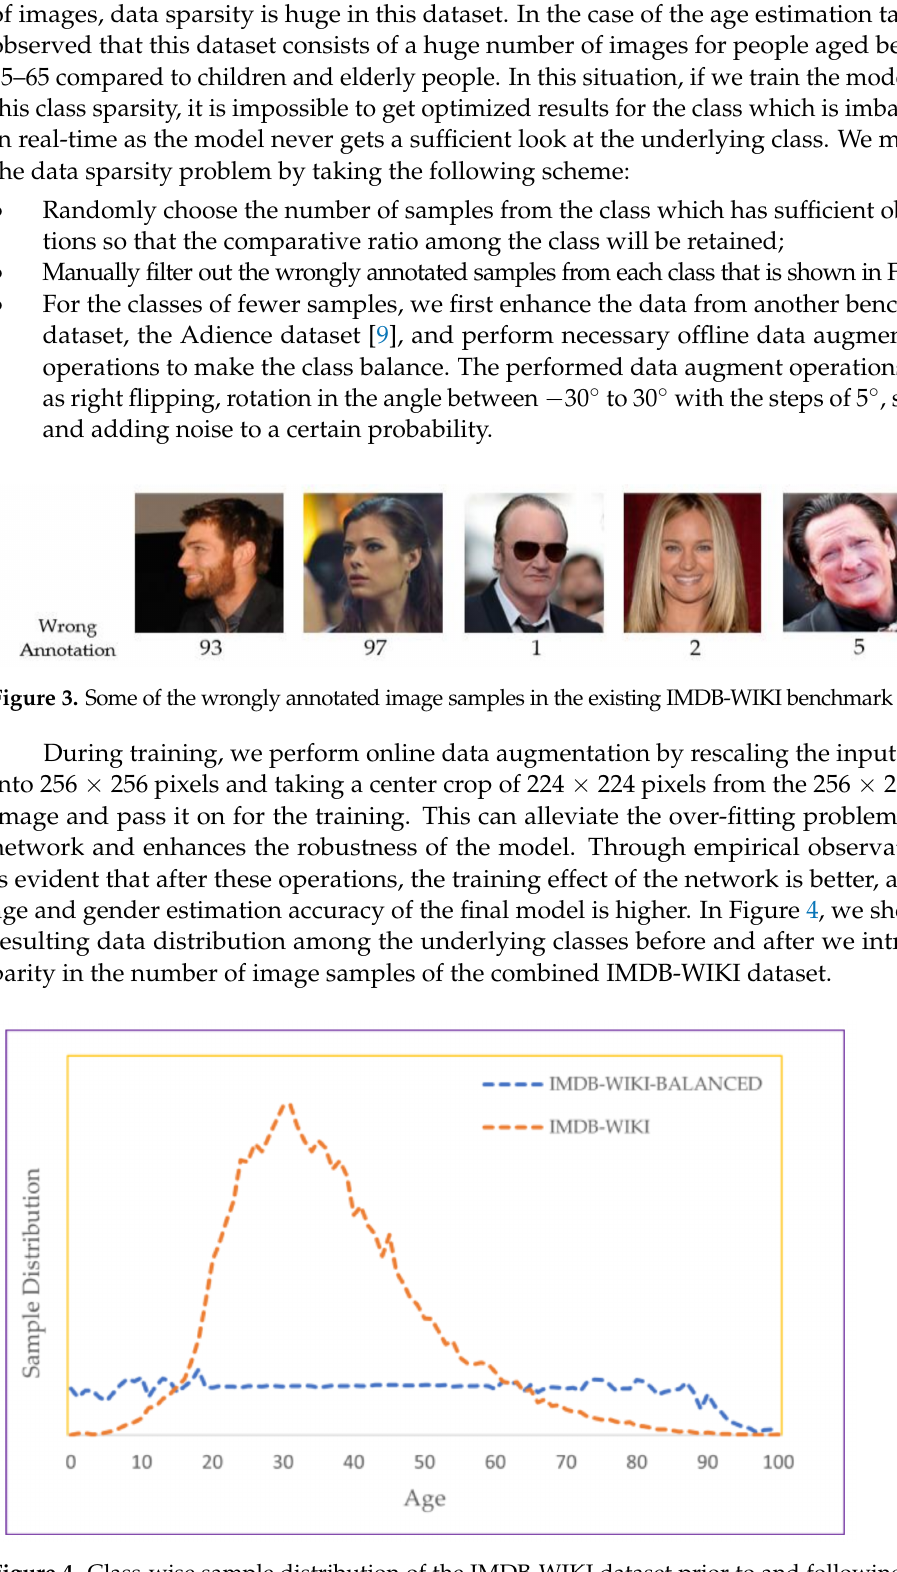
Figure 4. Class-wise sample distribution of the IMDB-WIKI dataset prior to and following parity among